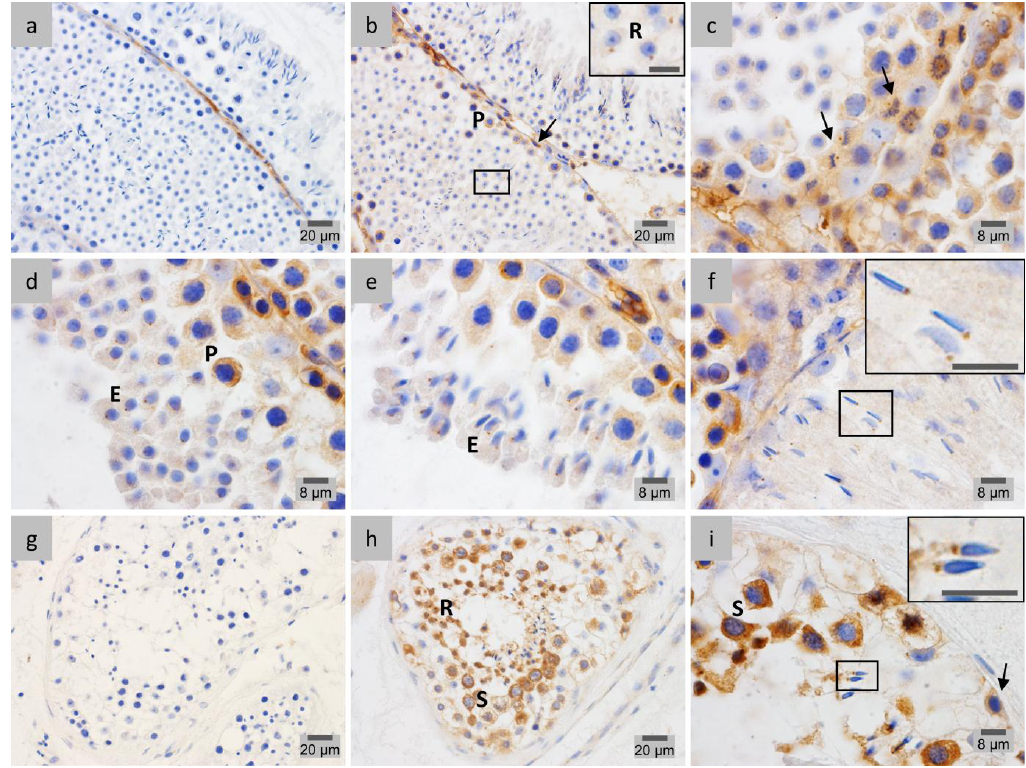
Figure 7. Immunohistochemical localization of γ -tubulin in mouse testis sections fixed in diluted Bouin’s solution ( a – f ) and human testis sections fixed in 4% PFA ( g – i ). Positive immunostaining appears in brown color and nucleus counterstaining with hematoxylin. ( a , g ) Negative controls showed γ -tubulin staining in the interstitial tissue. ( b ) In mouse seminiferous tubules, γ -tubulin is present in the cytoplasm of pre-meiotic germ cells, namely spermatogonia (arrow) and pachytene spermatocytes (P). From meiosis onwards, γ -tubulin concentrates in dots at the centriolar poles, starting in round spermatids (R) (ROI, scale bar: 8 µ m). ( c ) Typically, spermatogonia undergoing mitosis also express γ -tubulin in centrosomes (arrows). ( d ) γ -Tubulin concentrates in the cytoplasm of pachytene spermatocytes (P). ( d , e ) As spermatid elongation proceeds, the dot at the centriolar pole remains in elongating spermatids (E). ( f ) Centriolar staining for γ -tubulin is observed until maturation of elongated spermatids (ROI, scale bar: 8 µ m). ( h ) In human testis, after meiosis, γ -tubulin accumulates in dots at the centriolar poles and is also distributed homogenously across the cytoplasm of round spermatids (R). ( i ) In pre-meiotic germ cells, from spermatogonia (arrow) to spermatocytes (S), γ -tubulin staining appears dispersed throughout the cytoplasm. In completely elongated spermatids, γ -tubulin (ROI, scale bar: 8 µ m) still concentrates in a dot at the centriolar pole. PFA: paraformaldehyde. ROI: region of